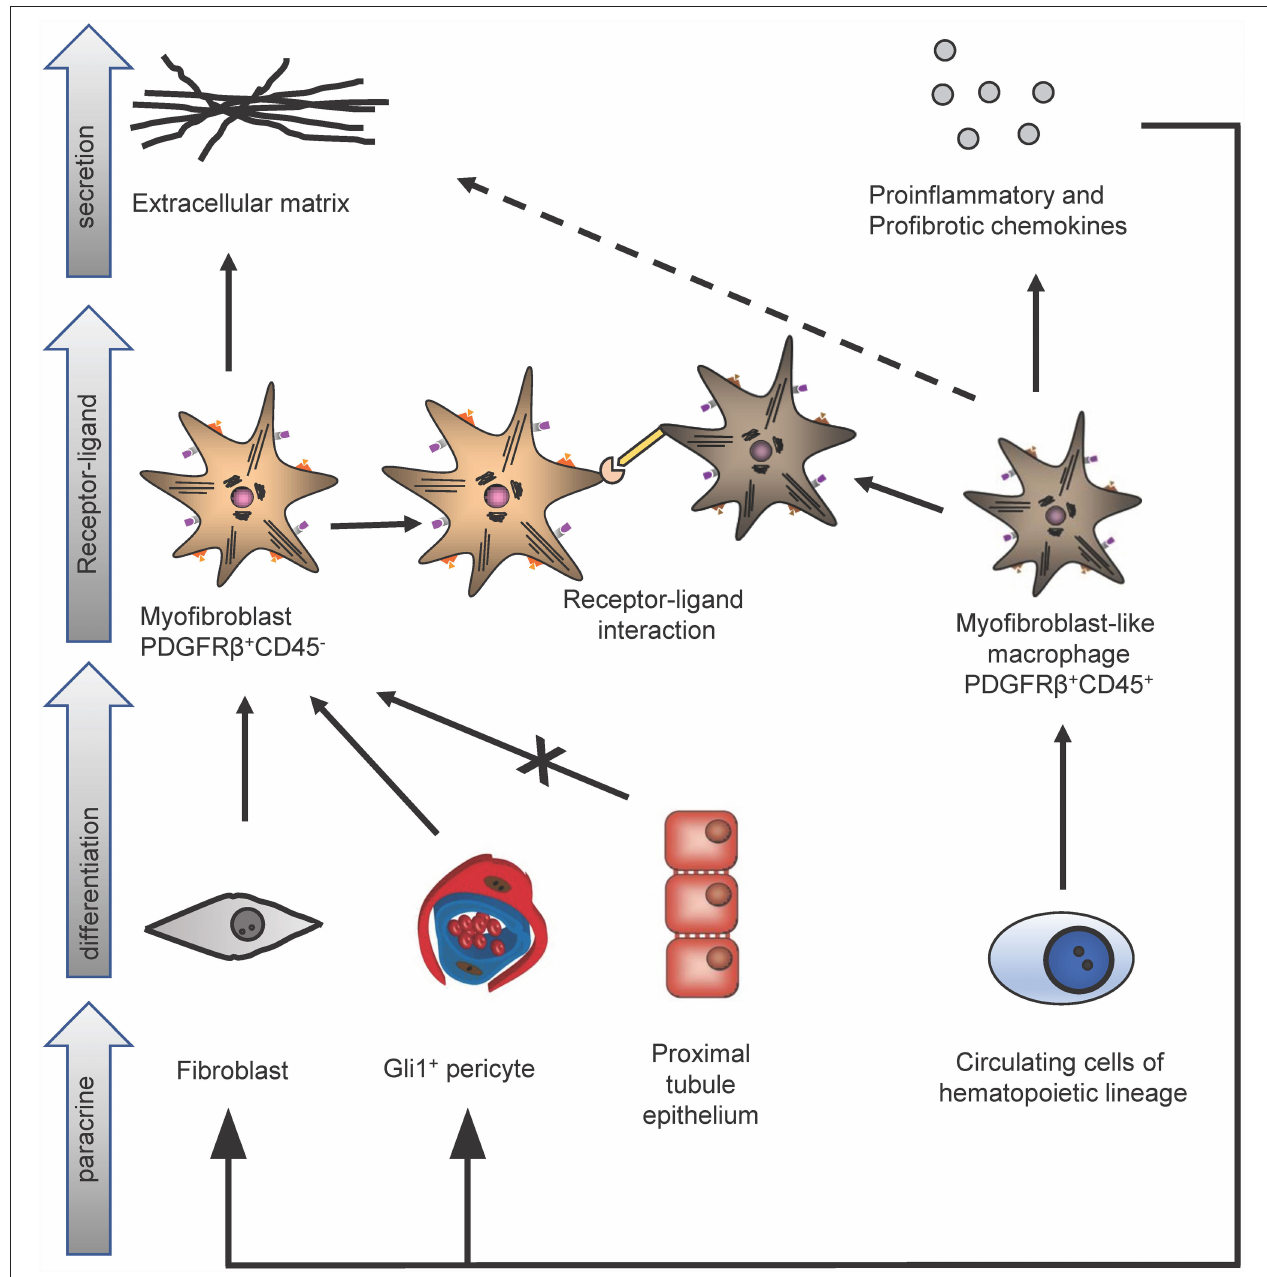
FIGURE 2 | Identification of different kidney myofibroblast subtypes in renal fibrosis. In kidney fibrosis two different types of myofibroblasts could be discriminated: PDGFR β + /CD45 − myofibroblasts and PDGFR β + /CD45 + myofibroblasts-like cells. PDGFR β + /CD45 − fibroblasts originate from pericytes and fibroblasts but not from proximal tubule epithelium and secrete extracellular matrix proteins. Circulating cells of the hematopoietic lineage differentiate in PDGFR β + /CD45 + myofibroblasts-like cells. These myofibroblasts-like cells secrete extracellular matrix, pro-inflammatory, profibrotic chemokines and interact via receptor-ligand-binding with PDGFR β + /CD45 −